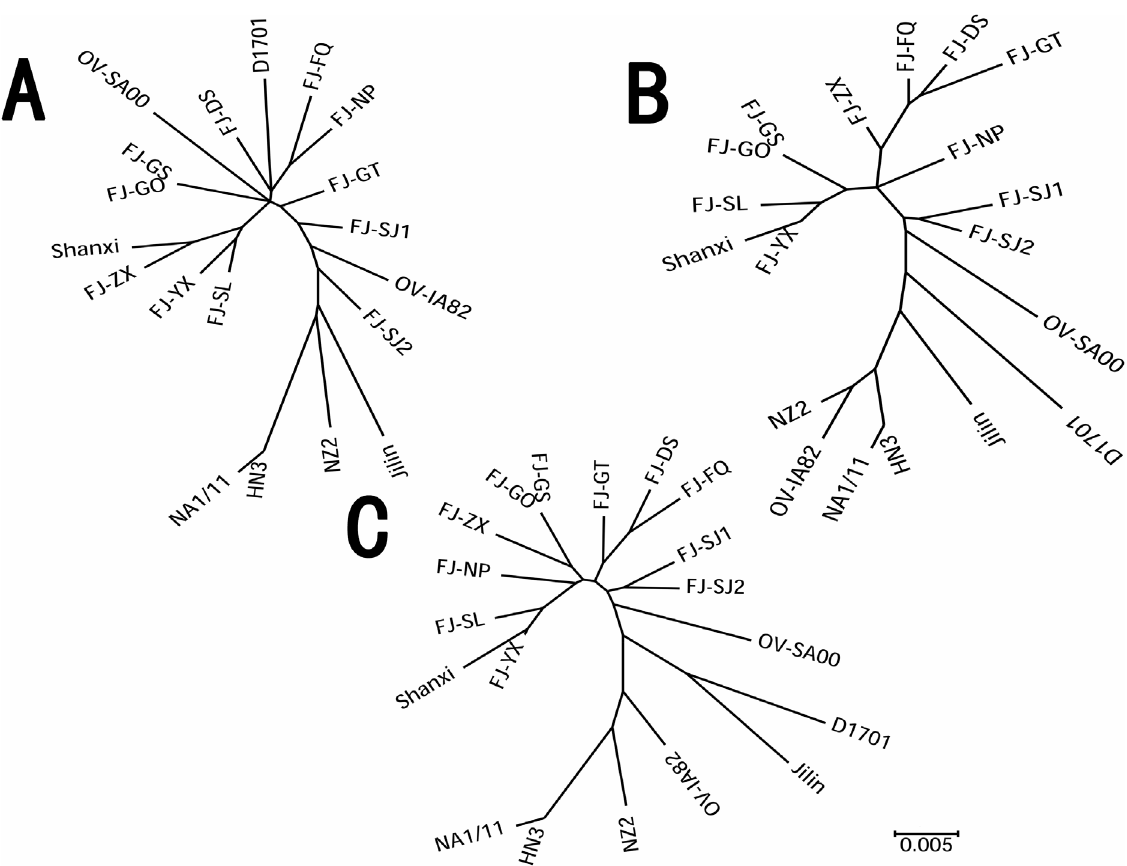
Figure 8. Phylogenetic analysis based on nucleotide sequences of ORFV011. (A). Phylogenetic analysis based on nucleotide sequences of ORFV059 (B).The phylogenetic based on nucleotide sequences of ORFV059(C) based on ORFV011 and ORFV059 with concatenated distance using MEGA 5.0. Tree was generated using by Maximum Likelihood Method using MEGA 5.0 software.